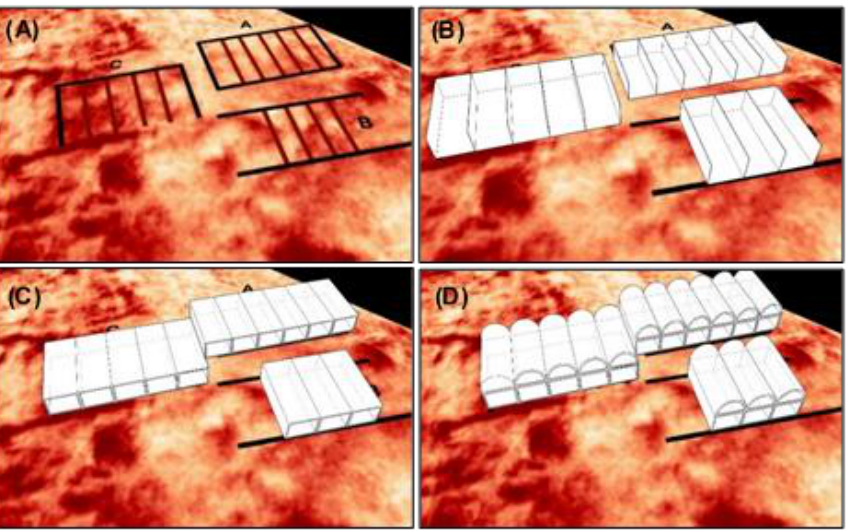
Figure 12. Process of constructing the 3D model for remotely sensed Installations A-C in SketchUp 524 Pro. 525